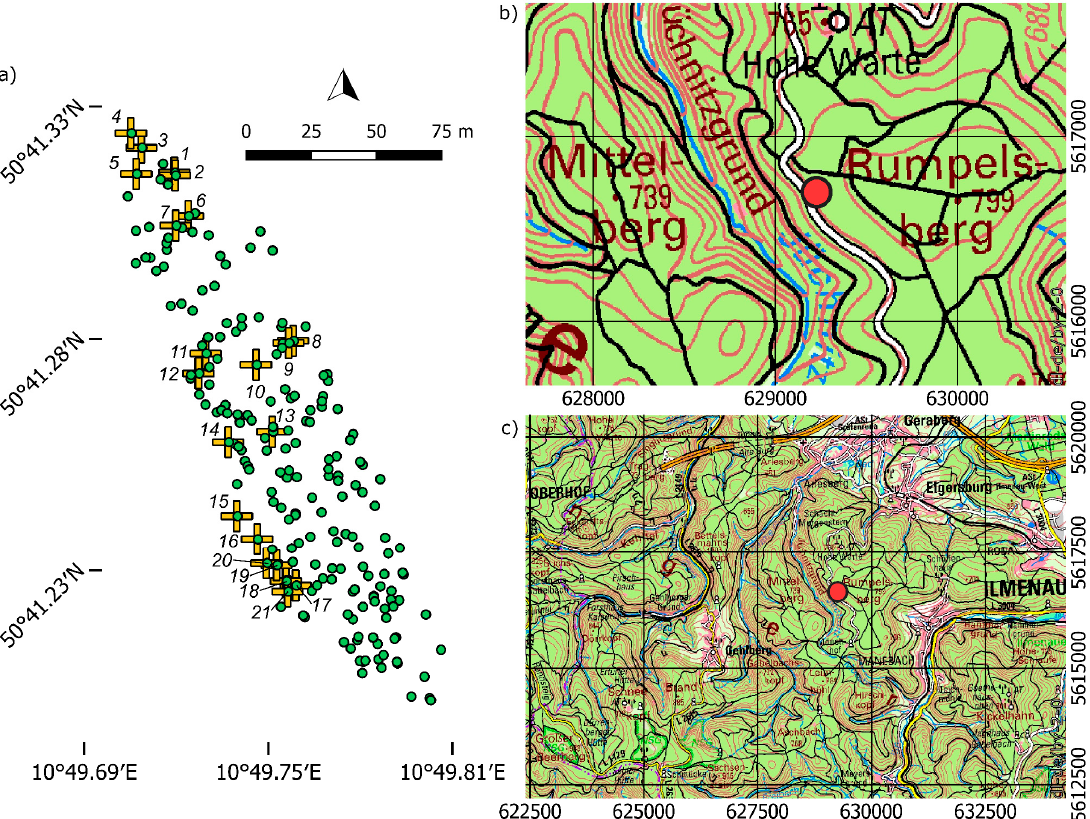
Figure 1. ( a ) Map of the 200 genotyped adult trees (green dots) including 21 seed-sampled mother trees labelled by numbers corresponding to the half-sib family numbers in Table 1 and depicted by yellow cross symbols over green dots. Coordinates are given in WGS 84 (EPSG: 4326). Topographic map at 1:25,000 ( b ) and 1:1000,000 ( c ) scales with the stand location indicated by the red dot. Coordinates are given in ETRS89 / UTM zone 32N (EPSG: 25832). Map source: www.geoportal-th.de [18], URI: L5330_col and C5530_col, respectively, and available under the “dl-de/by-2-0” licence at http://www.govdata.de/dl-de/by-2-0. Figure generated with QGIS 3.8.